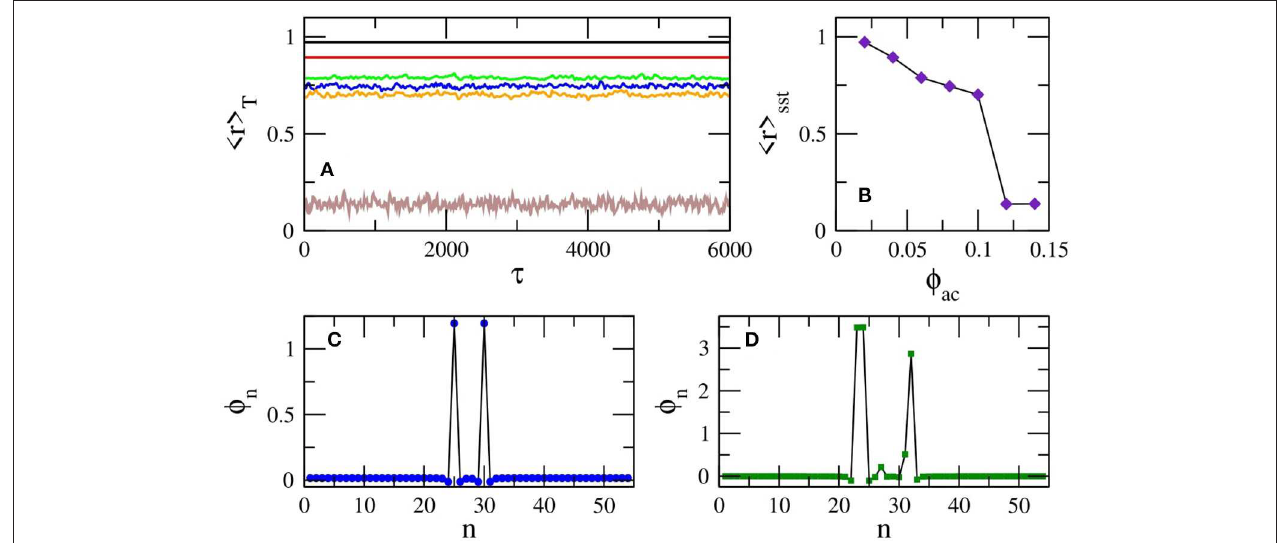
r , as a function of time τ for β L 0.86, γ 0.01, λ 0.02, h i T = = = − 0.08 (blue), φ ac 0.10 (orange), φ ac 0.12 (brown). (B) The = = = r , as a function of the ac flux amplitude φ ac . The other h i sst 0.04 and the other parameters =